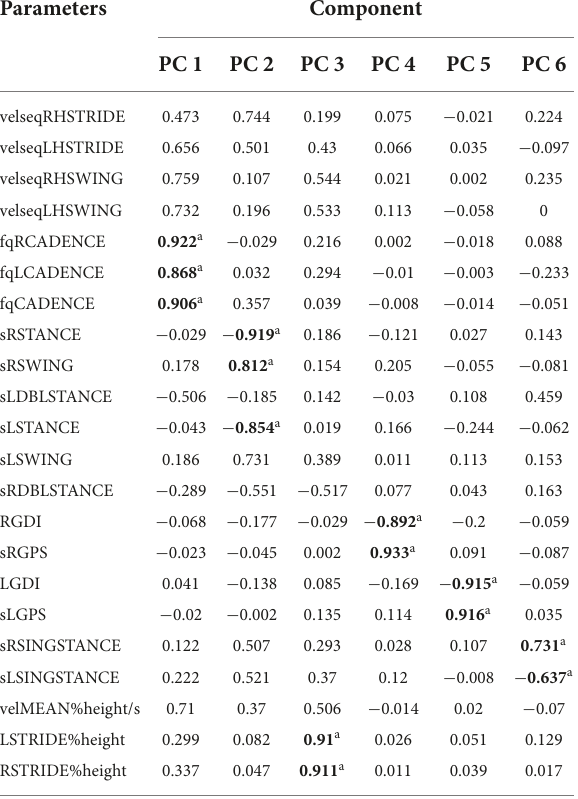
TABLE 3 Results of principal component analysis of WMT.